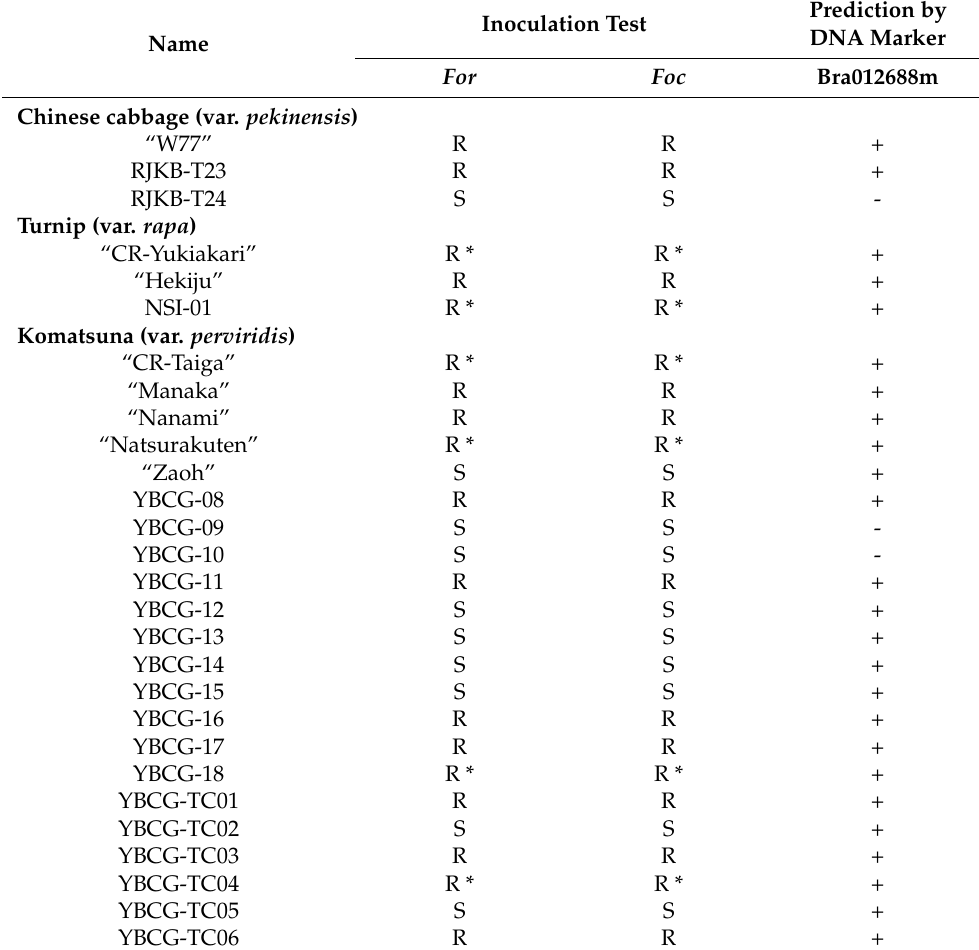
Table 1. Assessment of Fusarium yellows resistance by inoculation